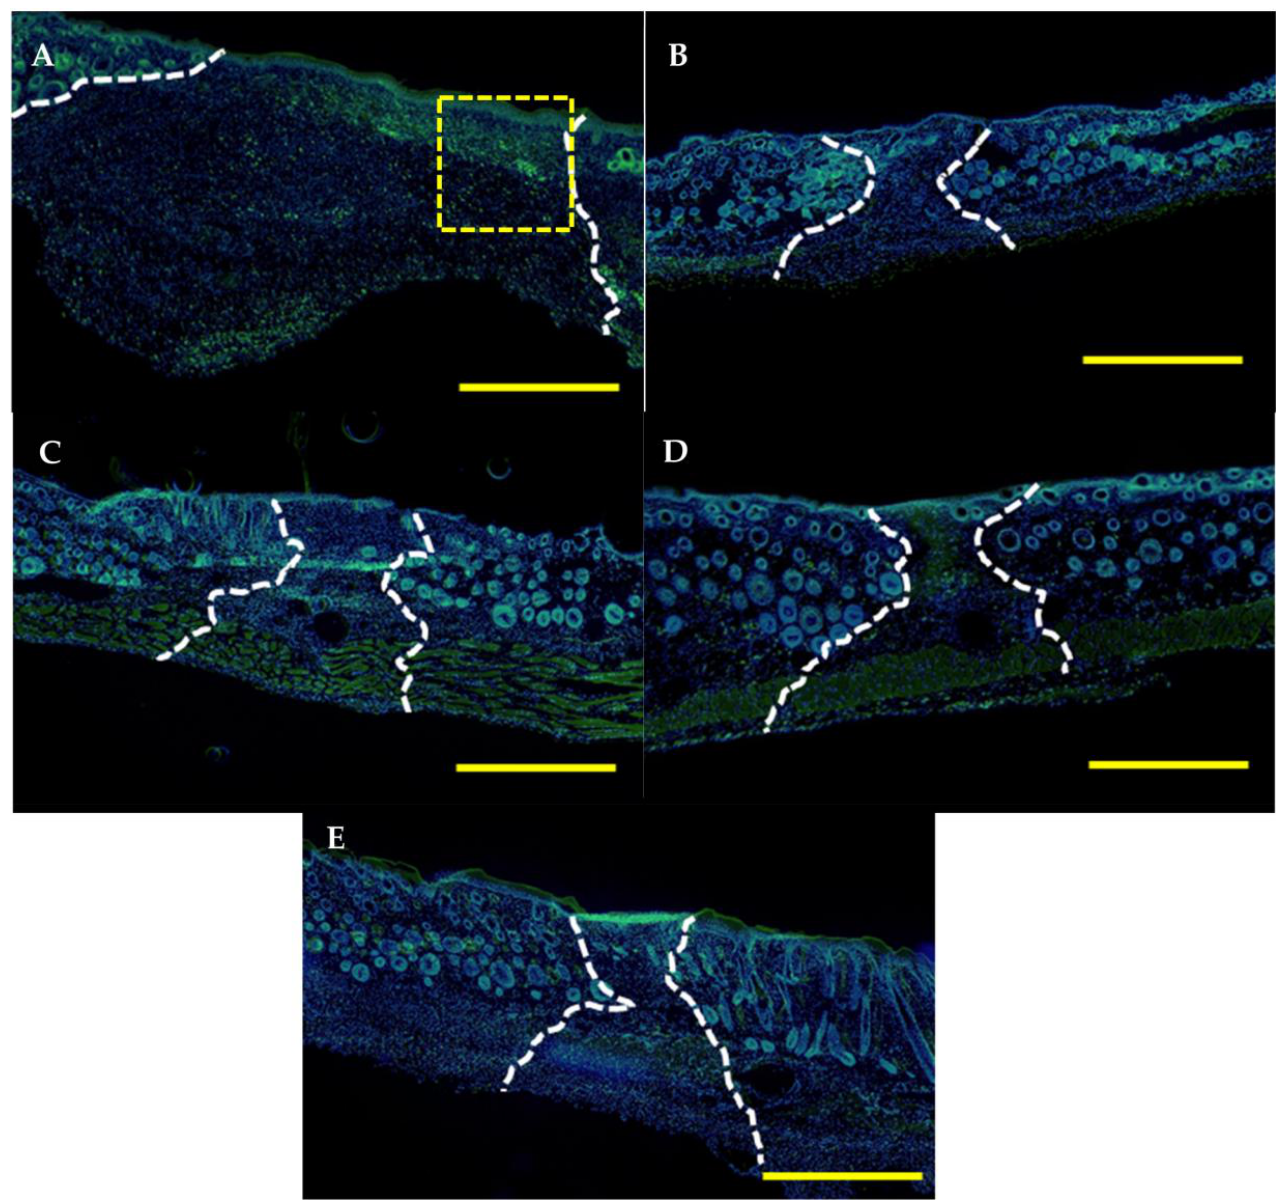
Figure 13. Representative CD68-DAPI immunological image of the harvested tissue on day 14 after treatment with control ( A ), PEG-D4-Si ( B ), PEG-D6-Si ( C ), PEG-D8-Si ( D ), and PEG-D6 ( E ). Yellow dash line box gives the example for the area used to calculate CD68-positive cells. White dash line indicates the wound proximities. Green = CD68-positive cells and blue = cell nucleus. Scale bars are 1 mm.